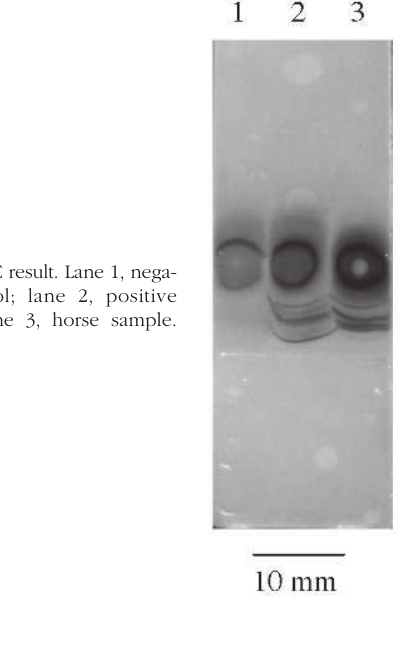
Fig. 2. – Real-time PCR result, showing the standard curves (Std), the horse sample and the negative control (NTC) curves obtained by plotting the nor- malised reporter (Rn) values against the cycle